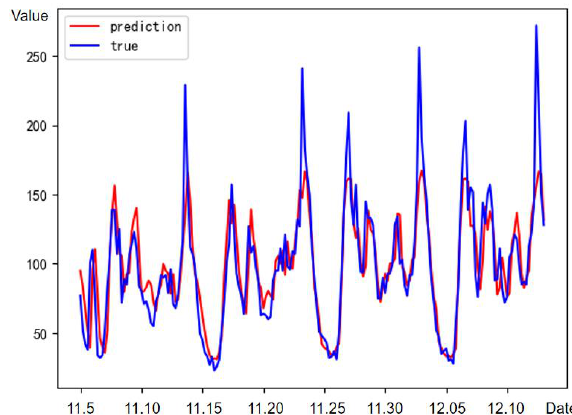
Figure 10 . Comparison of predicted results and true values.